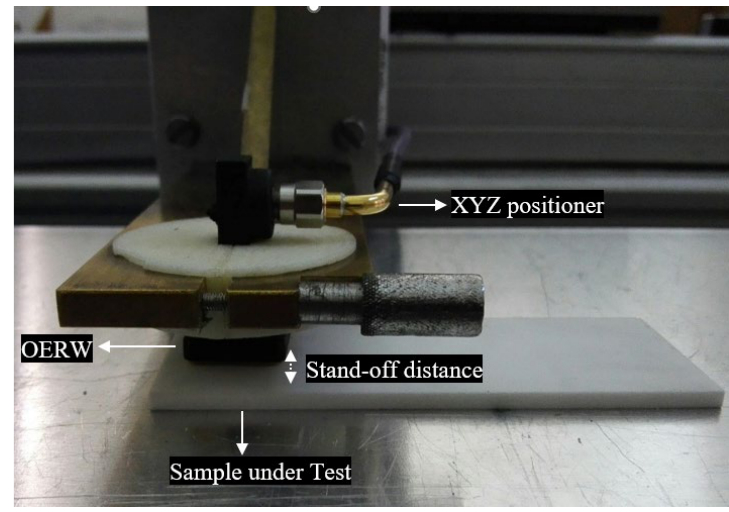
Figure 6. Setup of the OERW inspection system.